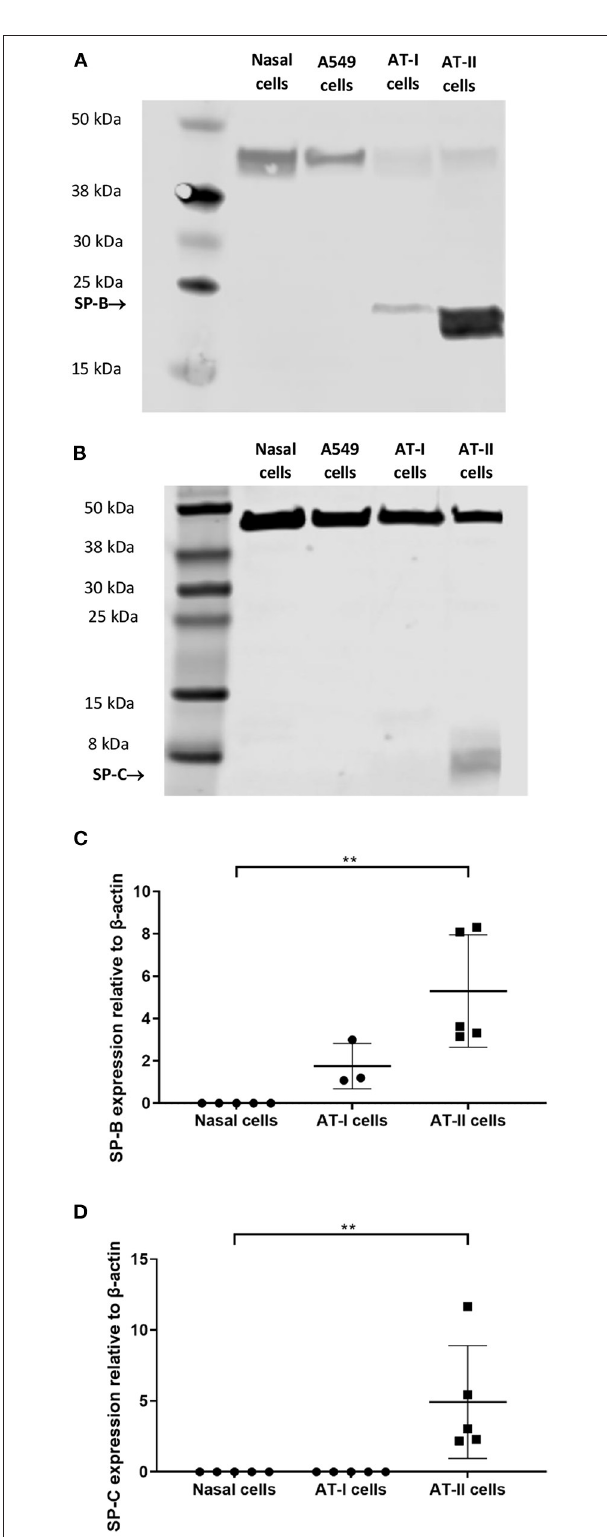
FIGURE 4 | Western blot analysis on primary nasal cell lysates. Expression of SP-B and SP-C in primary nasal cell ( n = 5), AT-I cells ( n = 4), and AT-II cell